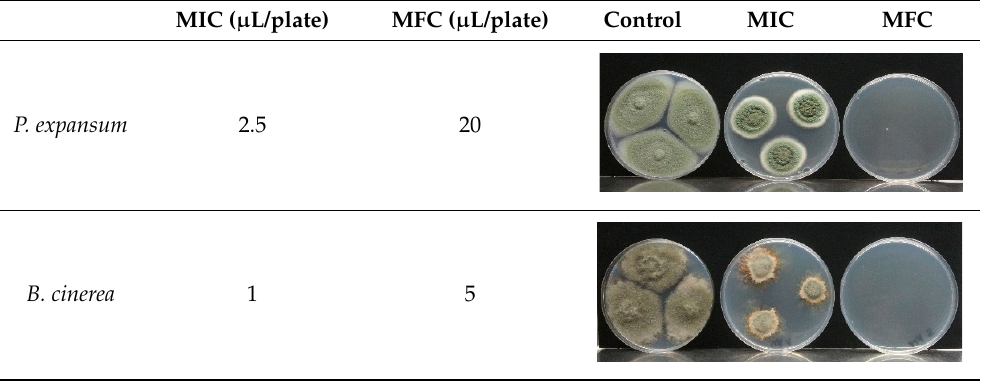
Table 5. Antimicrobial effectiveness of methyl anthranilate against P. expansum and B. cinerea ex- pressed as MIC and MFC (µL/plate) after 10 days of incubation at 26 °C. MIC ( µ L/plate) MFC ( µ L/plate)